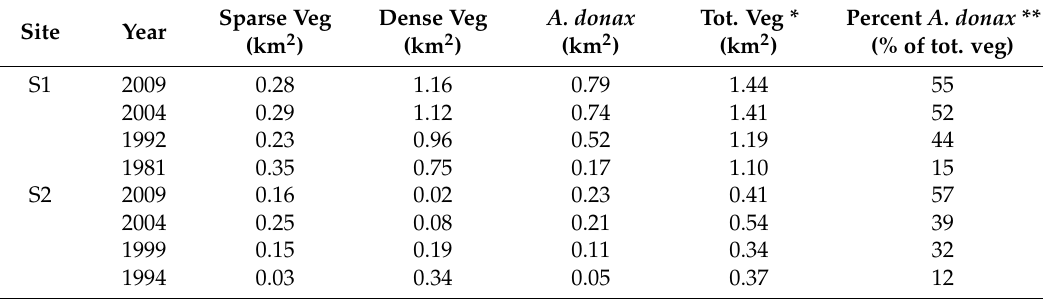
Table 6. Summary of results of vegetation mapping for sites S1 and S2.